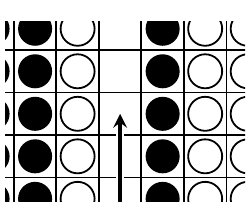
Figure 19. WHITE